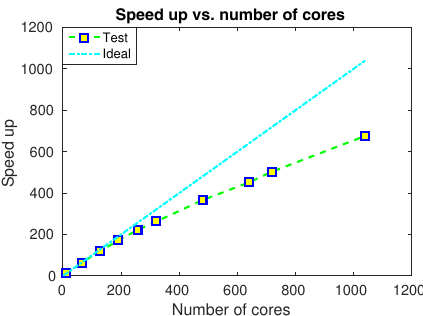
Figure 3. Strong scalability test result.